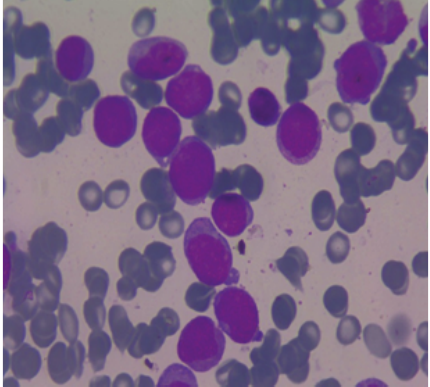
Figure 2: The view of myeloblasts on bone marrow aspiration material ( × 1000, Giemsa stain).